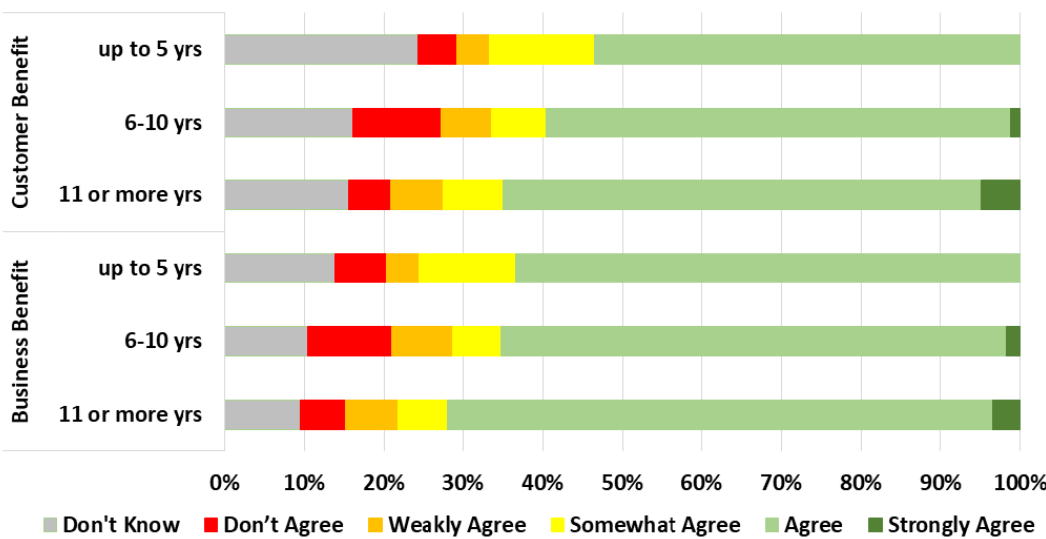
Figure 3. Within each beneficiary group (y-axis), depending on the level of the experts’ years of industry experience (inner y-axis): the relative percentage response (x-axis) for each agreement level (coloured)